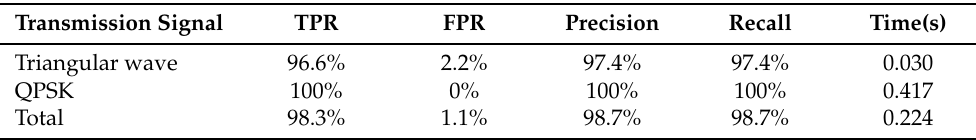
Table 3. Detection performance of the absent